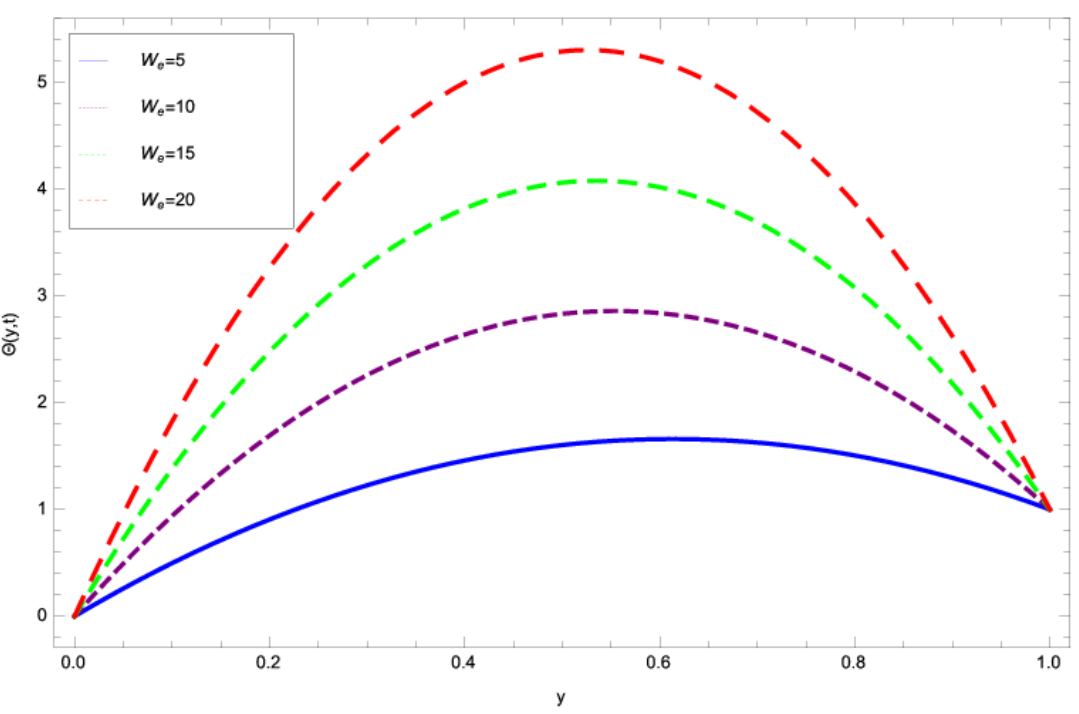
Figure 11. The effect of the Williamson number during temperature distribution, when m = 0.5; Ec = 8; M = 0.5; ω = 0.3; t = 1. Appl. Sci. 2017 , 7 , 369